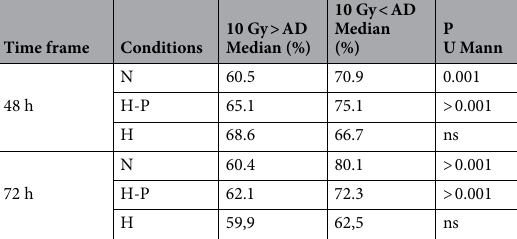
Table 4. Differences in the percentage of reduced Alamar Blue in wells in which absorbed dose (AD) was higher or lower than 10 Gy. Calculations for 96 h were not